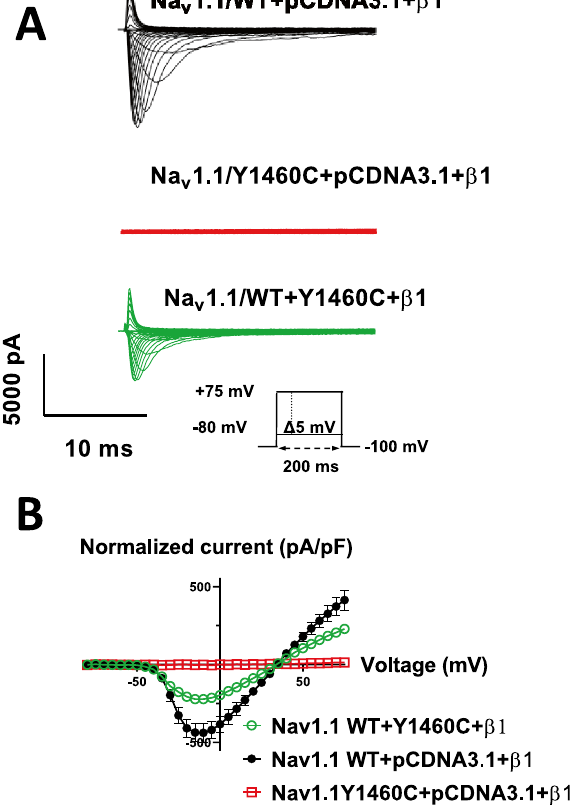
Figure 2. Whole-cell Na + currents recorded from HEK 293 cells. ( A ) Example of raw current traces from Na V 1.1/WT with Y1460C or empty vector (pCDNA3.1) and Y1460C were obtained using depolarizing pulses from − 80 to + 75 mV in 5-mV increments in a 15 mM Na + solution. ( B ) Analysis of whole-cell Na + currents recorded from HEK 293 cells expressing Na V 1.1 WT with Y1460C or pCDNA3.1 and Y1460C. Current density–voltage relationship of WT with pCDNA3.1 (Black symbols, n = 13), WT with Y1460C (Red symbols, n = 13), and Na V 1.1/Y1460C (Green symbols, n = 6), the standard errors are smaller than the symbols. Current amplitudes were normalized to membrane capacitance to obtain the current density (pA/pF).